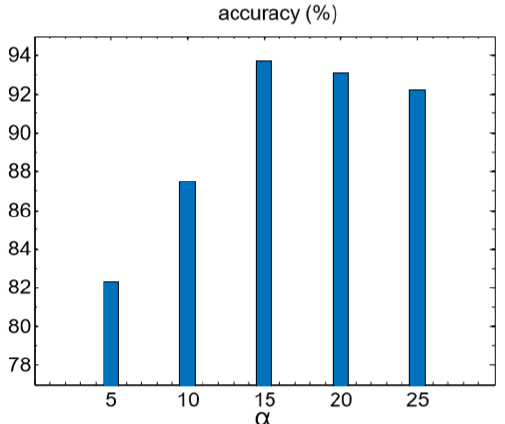
Figure 5. The retrieval performances achieved by varying α .